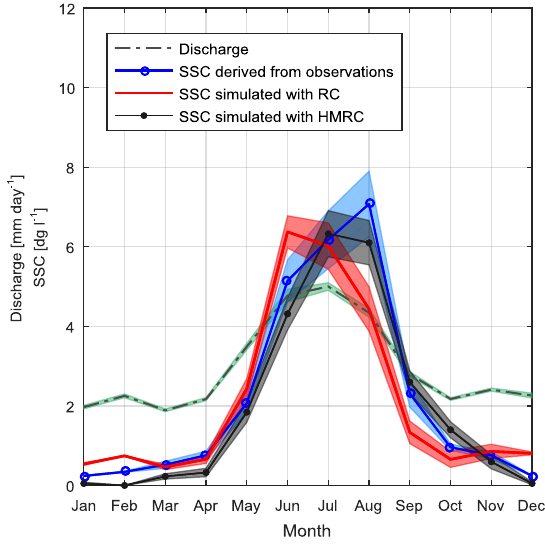
Figure 5. Mean monthly values of discharge measured at the outlet of the catchment (dash–dot grey line), SSC t derived from observa- tions of NTU (solid blue line with circles), SSC t simulated with the traditional RC (solid red line), and with the HMRC (solid black line with dots). Coloured shaded areas represent the range corre- sponding to ± standard error. Mean values and standard errors are computed over the entire observation